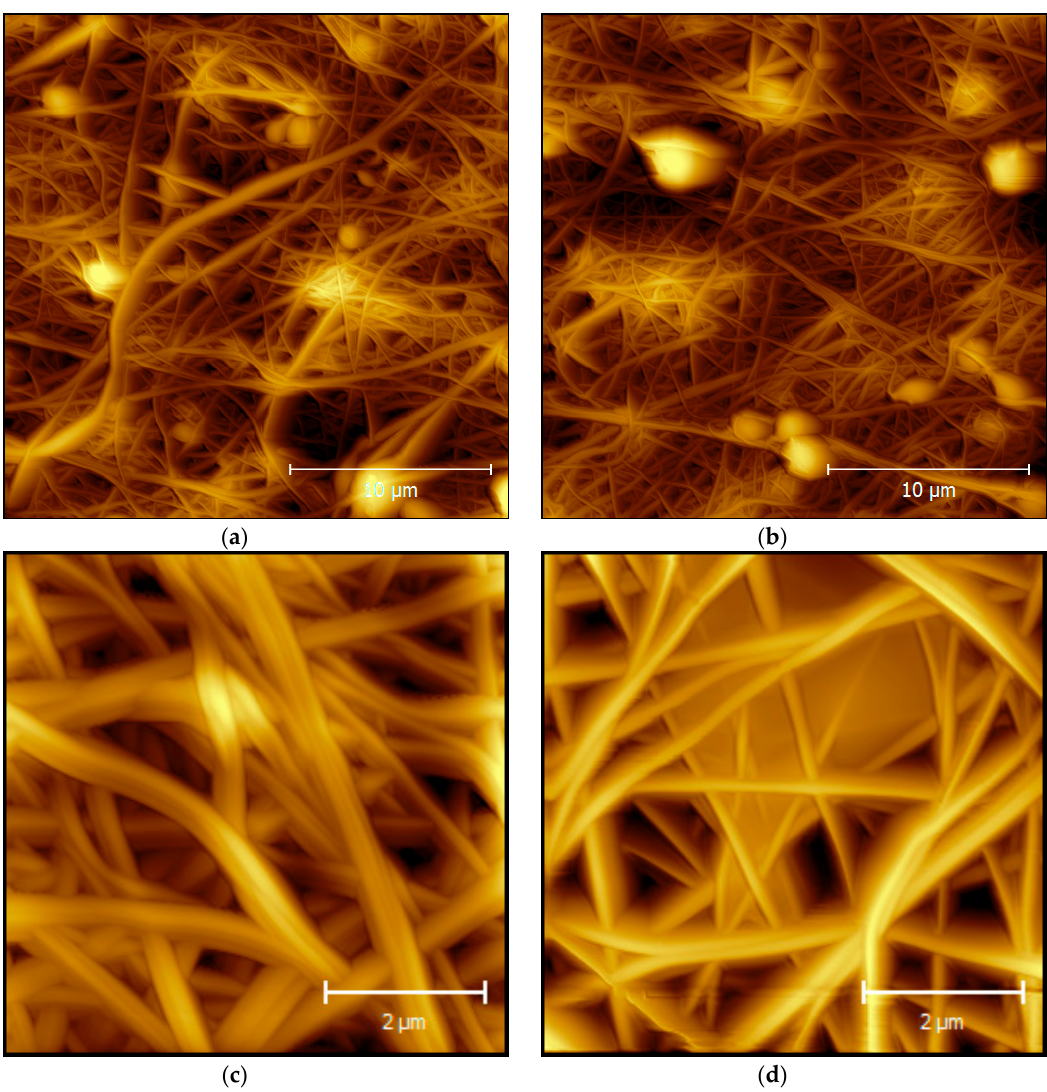
Figure 3. AFM images of electrospun PAN nanofiber mats with spinning parameters 240 mm/80 kV, corresponding to Figure 1e, taken on different positions ( a,b ) with a side length of 25 µm; ( c,d ) with a side length of 6.25 µm. (a) from [42], modified.